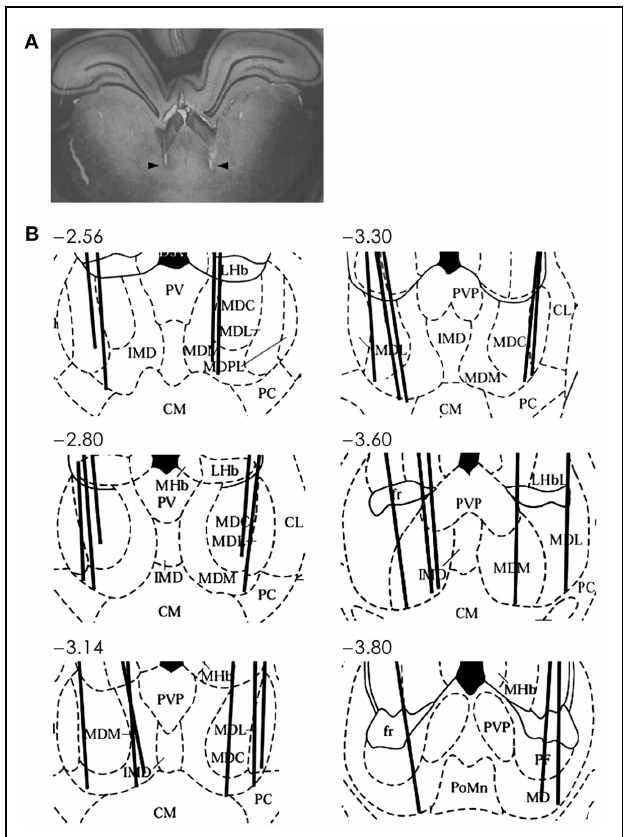
FIGURE 2 | Recording sites in the MDN. (A) An example photomicrograph (coronal section; approximately 3.6mm posterior to bregma) showing two electrode tracks (arrows). (B) Reconstruction of electrode tracks. Each solid line denotes one tetrode track. Numbers indicate distances (mm) from bregma. AD, anterodorsal thalamic nucleus; CM, centralmedial thalamic nucleus; CL, centrolateral thalamic nucleus; D3V, dorsal third ventricle; IMD, intermediodorsal thalamic nucleus; LHb, lateral habenular nucleus; LHbL, lateral habenular nucleus, lateral; LHbM, lateral habenular nucleus, medial; MD, mediodorsal nucleus; MDC, central segment of mediodorsal nucleus; MDL, lateral segment of mediodorsal nucleus; MDM, medial segment of mediodorsal nucleus; MDPL, paralaminar segment of mediodorsal thalamic nucleus; MHb, medial